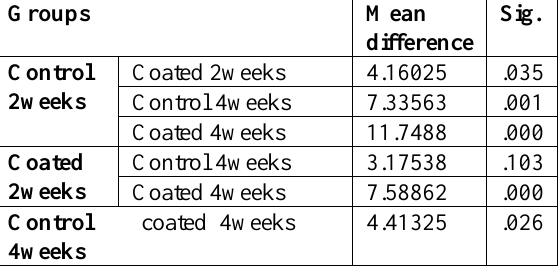
Table 2: Multiple Comparison (LSD) among all Pairs of Different Periods of Healing Times in Each Group of CpTi Implant Screws Independently